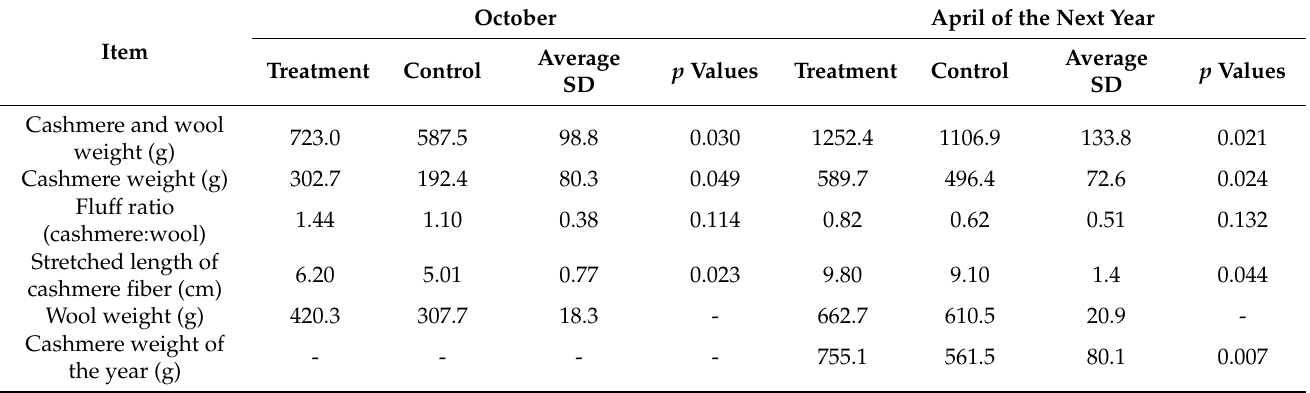
Table 3. The effect of short photoperiods on cashmere growth and